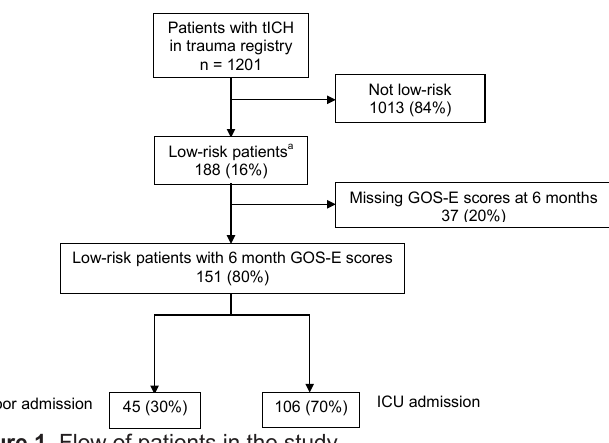
Figure 1. Flow of patients in the study.